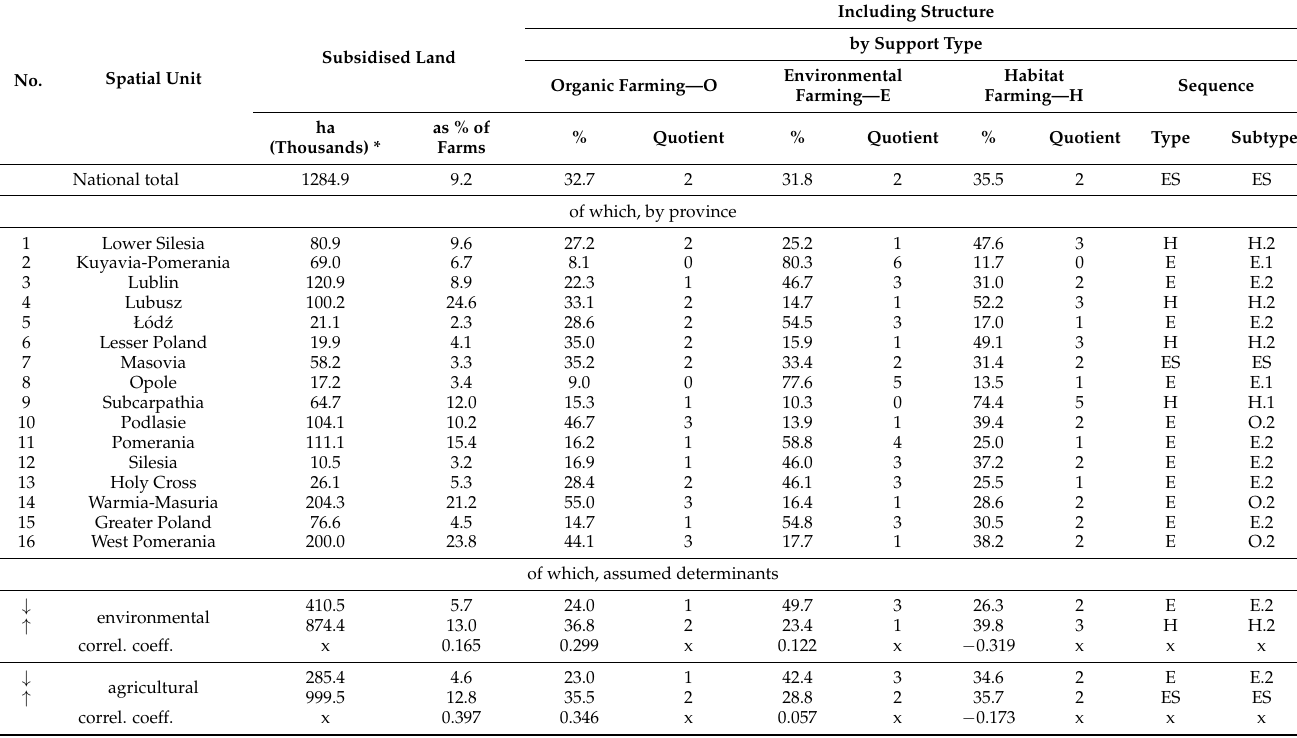
Table 2. Forms of green support for agriculture in Poland: level, structure and determinants.